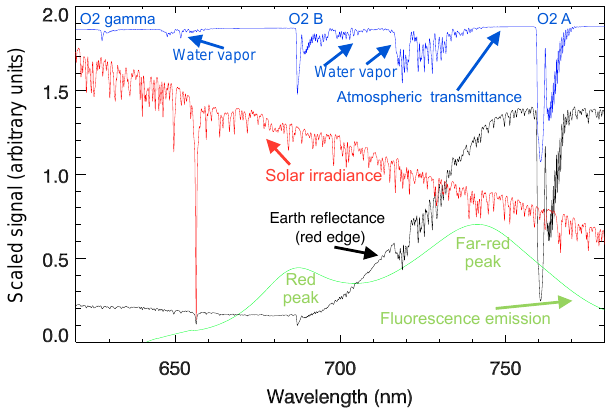
Figure 1. Simulated typical terrestrial spectra (atmospheric trans- mittance, reflectance, SIF emissions, and solar irradiance as a function of wavelength) computed for an instrument with FWHM =